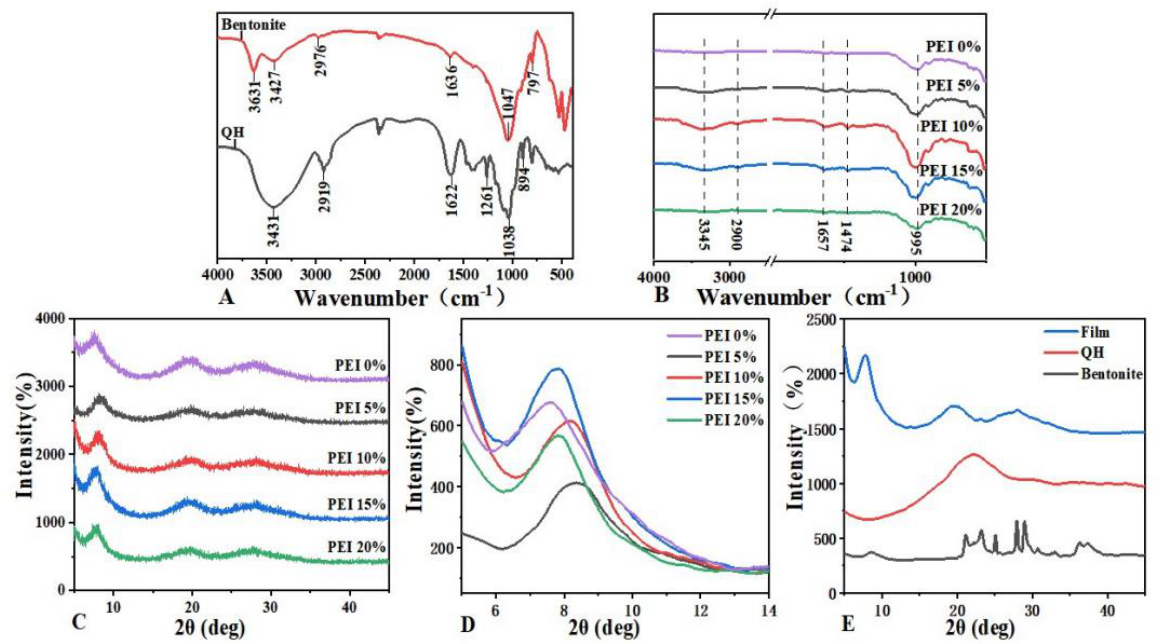
Figure 1. The FT-IR of bentonite and quaternizated hemicelluloses ( A ), the FT-IR of the five composite films ( B ), the XRD patterns of the five composite films ( C ), the XRD patterns of composite films in 5–14° ( D ), the XRD patterns of QH, bentonite and composite film ( E ).